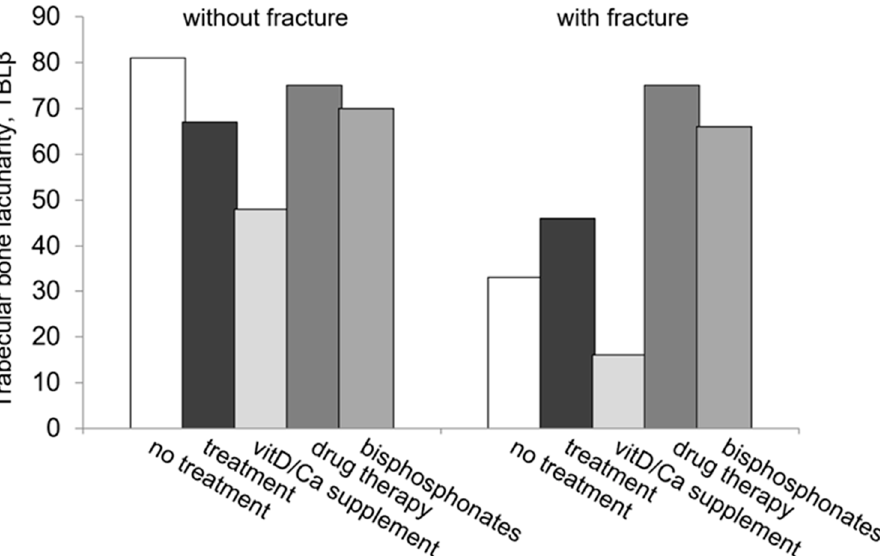
Figure 1. The effect of osteoporosis treatment on TBA as measured using TBL β in over-50s women with (right) and without (left) prevalent bone fragility fracture. TBA: trabecular bone microarchitec- ture; TBL β : trabecular bone lacunarity parameter β as an index of fracture risk. Table 3. TBL β as an index of therapy efficacy on osteoporotic fracture risk.